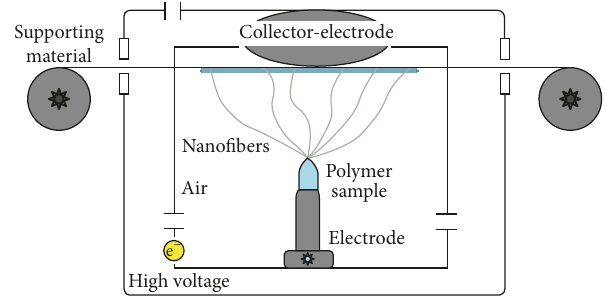
Figure 1: Elmarco